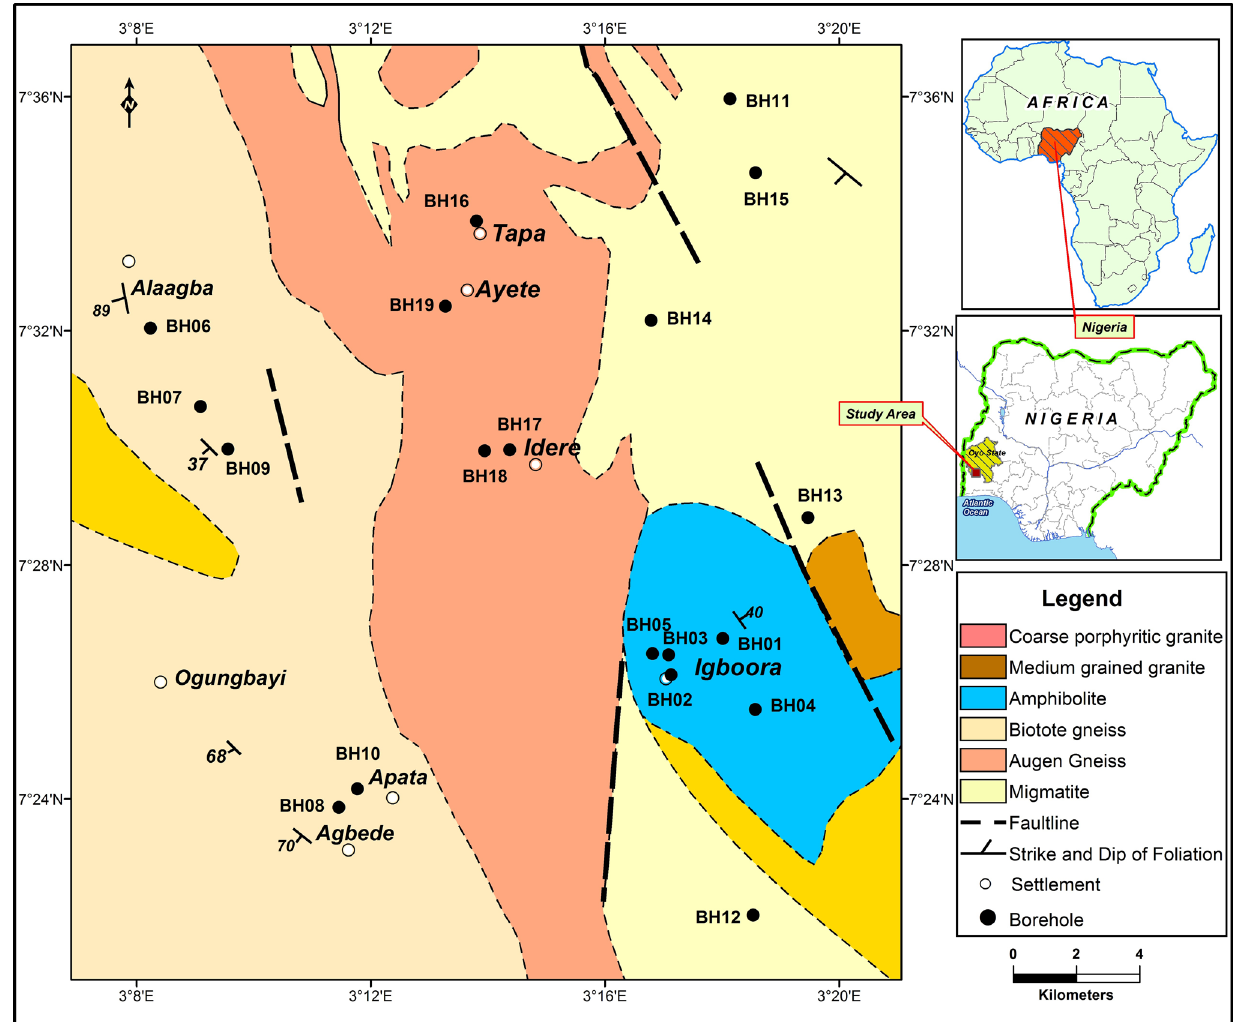
Fig. 4 Borehole locations on geological